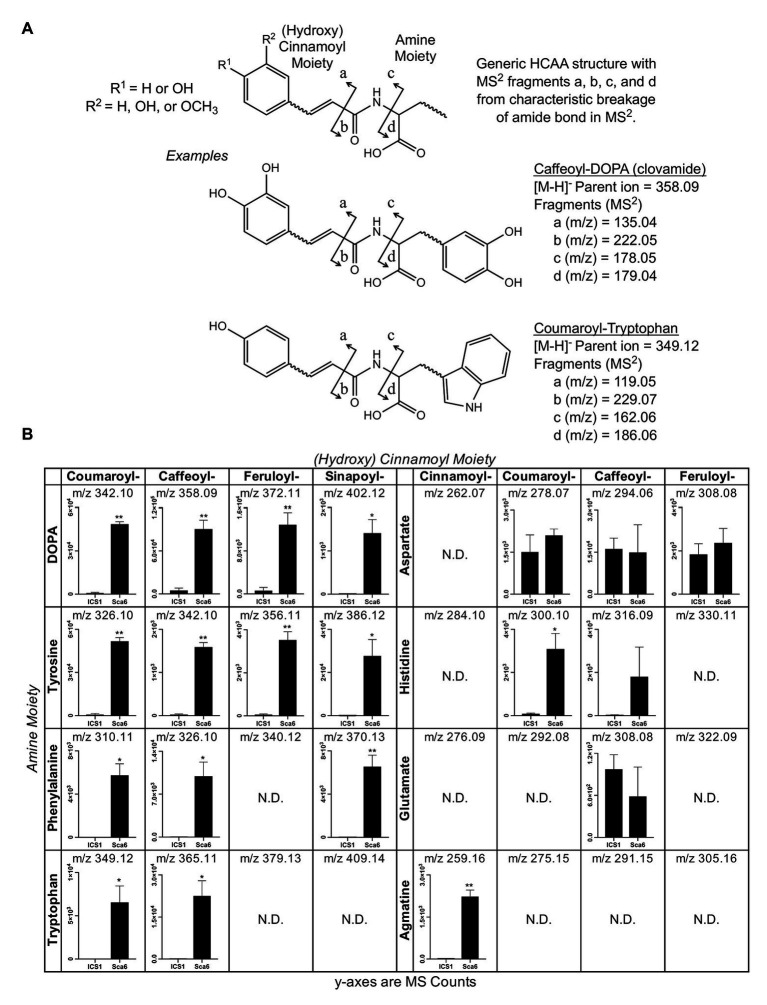
Semi-targeted LC-MS/MS analysis of HCAAs in leaf tissue (‘ICS1’ and ‘Sca6’). (A) Generic HCAA structure and diagnostic MS/MS fragments based on clovamide fragmentation (Arlorio et al., 2008) used to predict HCAAs in LC-MS/MS data. Two examples, Caffeoyl-DOPA (clovamide) and Coumaroyl-Tryptophan, are shown. (B) Relative abundance of putative HCAAs detected in LC–MS data. “N.D.” = not detected. *
p < 0.05, **
p < 0.01 (Welch’s t-test), n = 3. Error bars represent standard deviation.